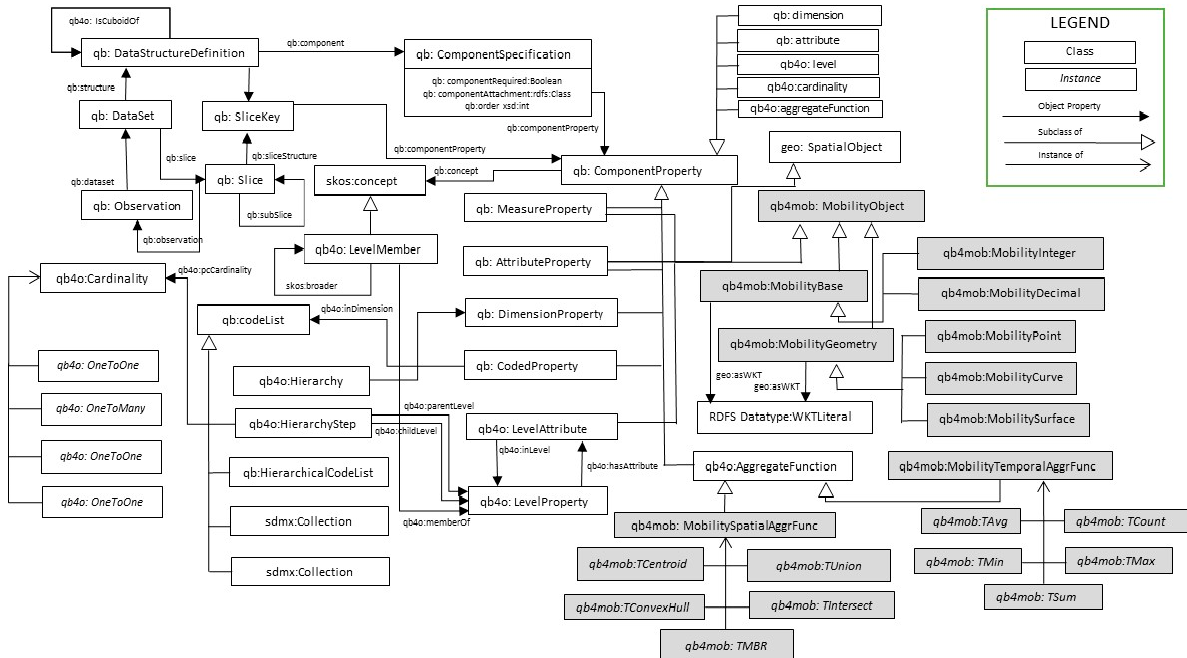
Figure 6. QB4MobOLAP Vocabulary.